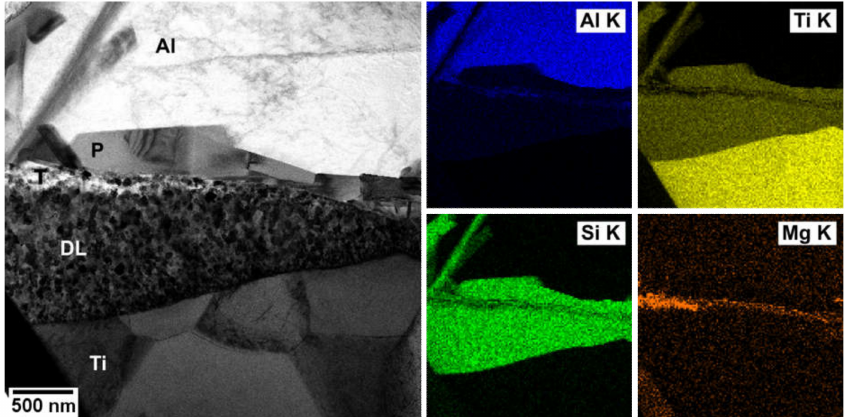
Figure 7. EDS map of the interface with precipitates and the diffusion layer. The concentrations of Al, Ti and Si are fairly homogeneous within each phase. Mg is segregated between the diffusion layer and the precipitate. The labels correspond to those in the Figure 5. Table 4. EDS analysis of the diffusion layer and individual powder particles, labels correspond to the labels in Figure 6b. The data are qualitative in nature. Mg Al Si Ti Analyzed Region (at.%) (at.%) (at.%) (at.%)